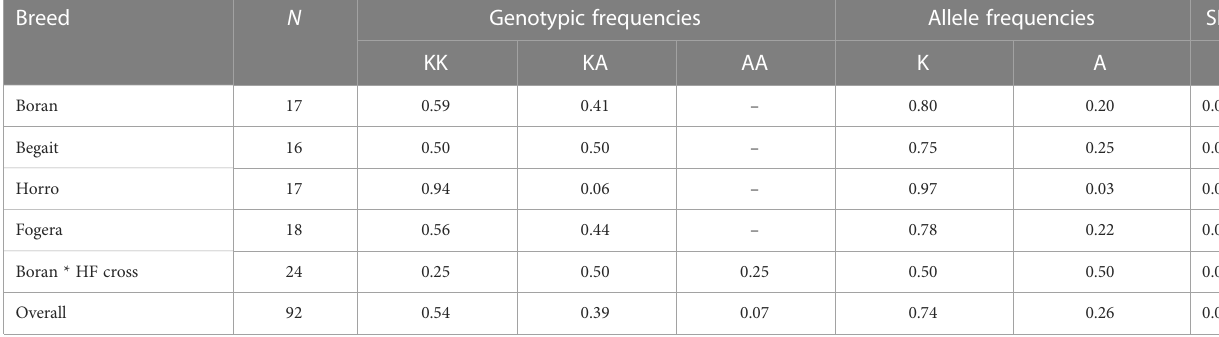
TABLE 2 Genotypic and allelic frequencies in exon 8 of the DGAT1 gene. Breed